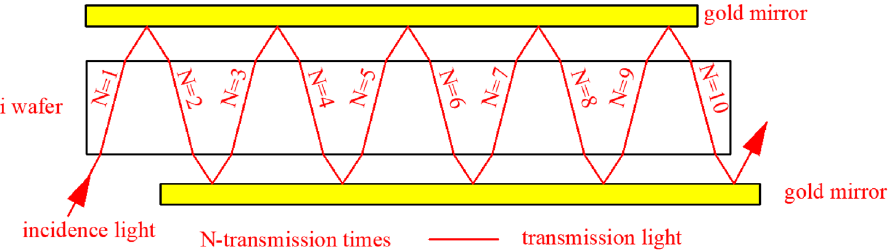
Figure 1. Schematic of the MTR equipment. The incident light undergoes multiple transmissions through and reflections on a silicon wafer placed between two gold mirrors. For clarity and simplicity, the transmitted light is shown without the reflected part. The red line indicates that the IR beam passes through the silicon chip N = 10 times. The maximum N can reach 14 by extending the length of the gold mirrors and silicon wafer. The image was created using AutoCAD 2014 (simplified Chinese), http://win.xmjfg